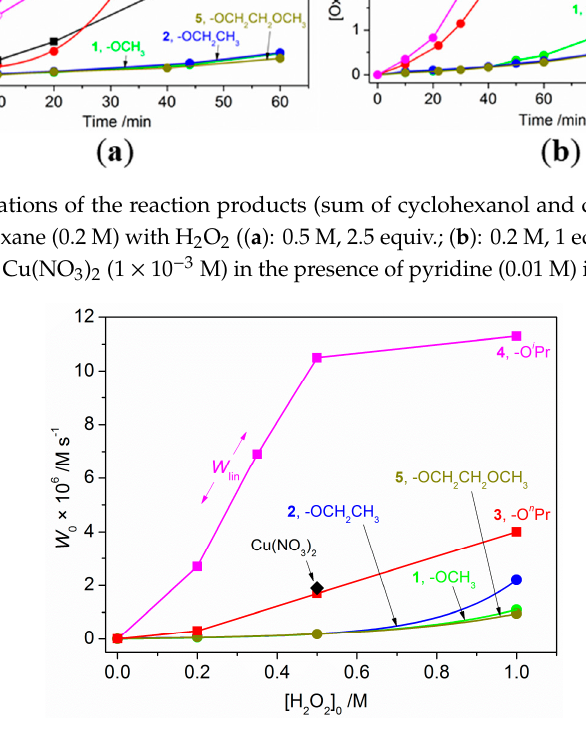
Figure 4. Accumulations of the reaction products (sum of cyclohexanol and cyclohexanone) in the oxidation of cyclohexane (0.2 M) with H 2 O 2 (( a ): 0.5 M, 2.5 equiv.; ( b ): 0.2 M, 1 equiv.) catalysed by 1 – 5 (1 × 10 − 3 M) and by Cu(NO 3 ) 2 (1 × 10 − 3 M) in the presence of pyridine (0.01 M) in acetonitrile at 50 °C.